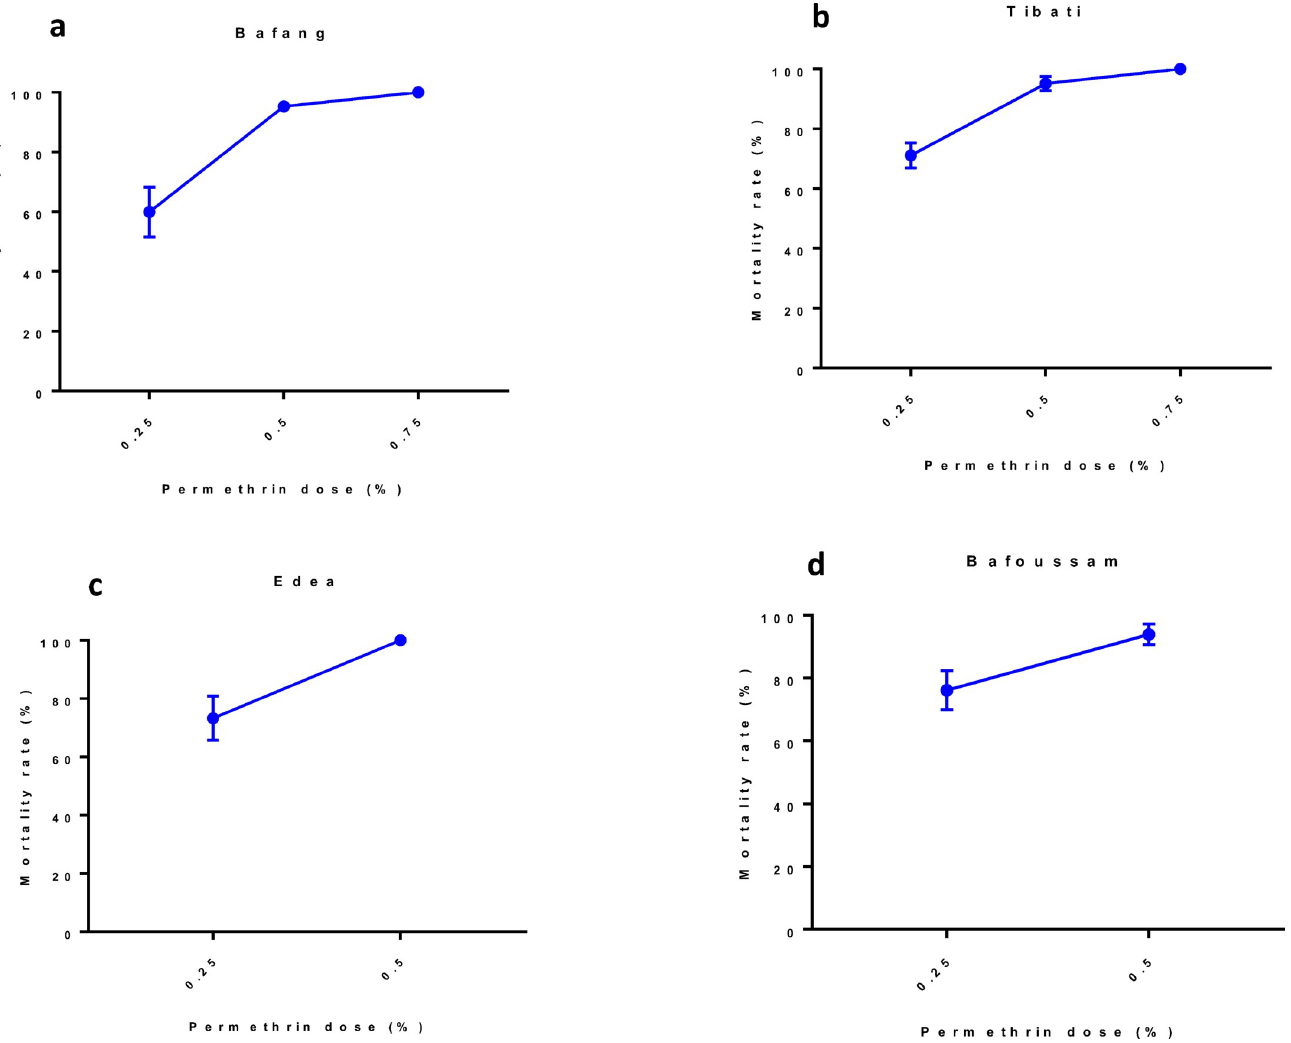
Fig 5. Tests with different doses of permethrin in A . albopictus from Cameroon. a, Bafang; b, Tibati; c, Ede´a; d, Bafoussam.